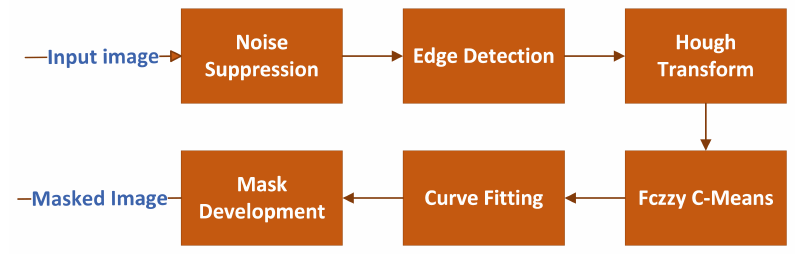
Figure 2. ROI extraction